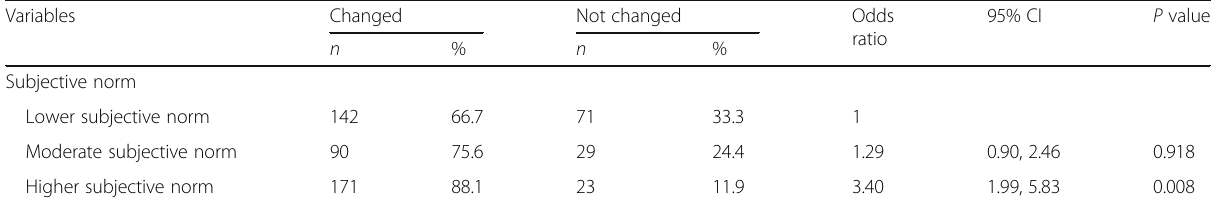
Table 2 Bivariate association with frequency of changing sanitary napkins in school toilets (Continued) Variables Changed Not